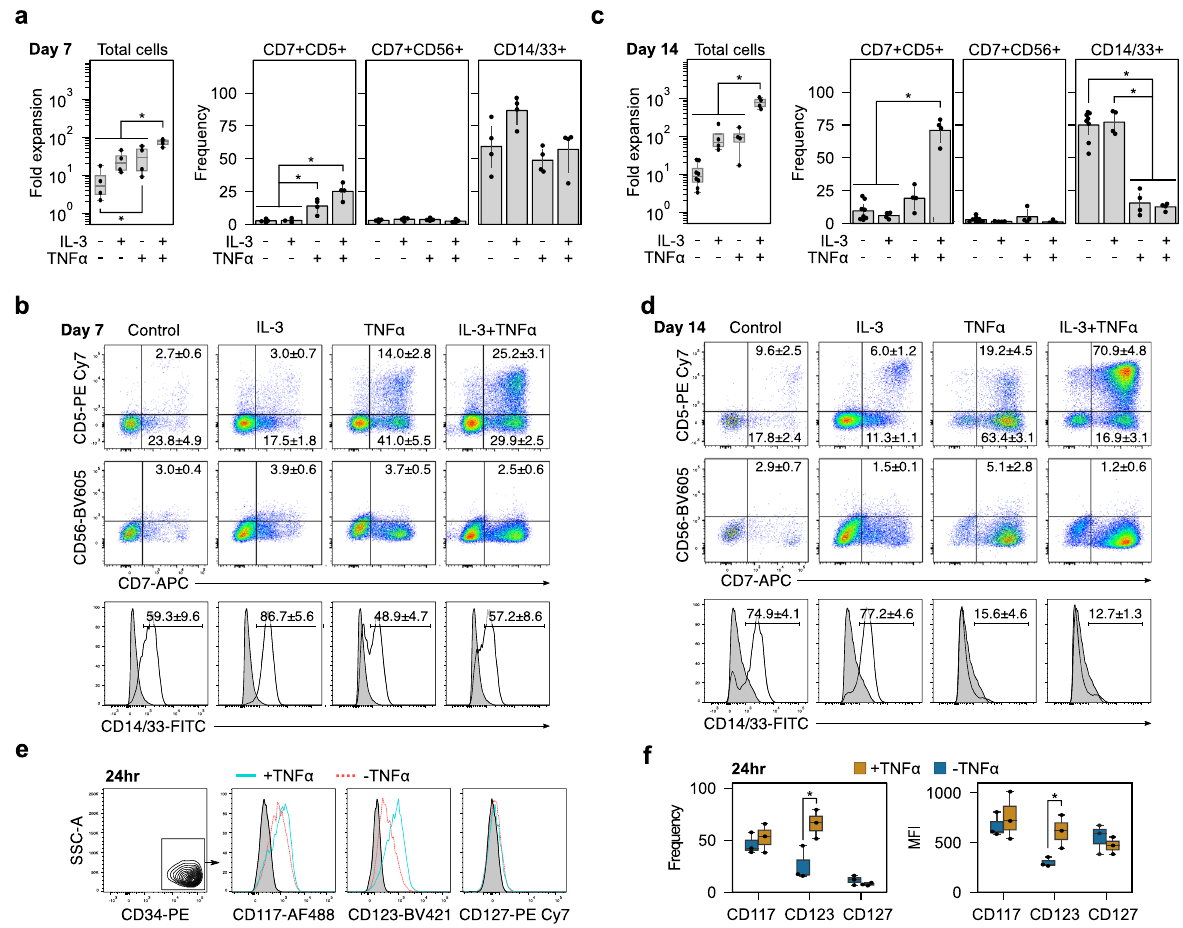
Fig. 3 IL-3 and TNF α enhance proT-cell expansion and purity. CD34 + HSPCs were placed on DL4 + VCAM-1 and fold expansion and phenotype were measured on days 7 and 14. a Fold expansion and frequency of CD7 + CD5 + proT, CD7 + CD56 + NK, and CD14/33 + myeloid cells on day 7. Combining TNF α with IL-3 signi fi cantly increased total cell expansion over all other conditions. It also increased the frequency of CD7 + CD5 + cells without increasing CD7 + CD56 + frequencies. Box plots show median and interquartile range from n = 4 independent UCB donors and bar plots are mean ± standard error (* p < 0.05). b Representative fl ow cytometry plots on day 7. Frequencies are mean ± standard error. c By day 14, the frequency of CD14/33 + cells was signi fi cantly lower in groups containing TNF α than those without. Box plots show median and interquartile range from n = 4 independent UCB donors and bar plots are mean ± standard error (* p < 0.05). d Representative fl ow cytometry plots from day 14 show a relatively pure population of CD7 + CD5 + cells when TNF α is combined with IL-3. Frequencies are mean ± standard error. e Representative fl ow cytometry plots of CD117, CD123, and CD127 expression on CD34 + HSPCs with or without TNF α stimulation for 24 h. f TNF α induced a signi fi cant increase in the frequency of CD123 + cells. The increased frequency of CD123 + cells was accompanied by an increase in the median fl uorescent intensity (MFI) of CD123, indicating a higher receptor density on the cell ’ s surface after TNF α stimulation. * p < 0.05 for n = 3 independent UCB